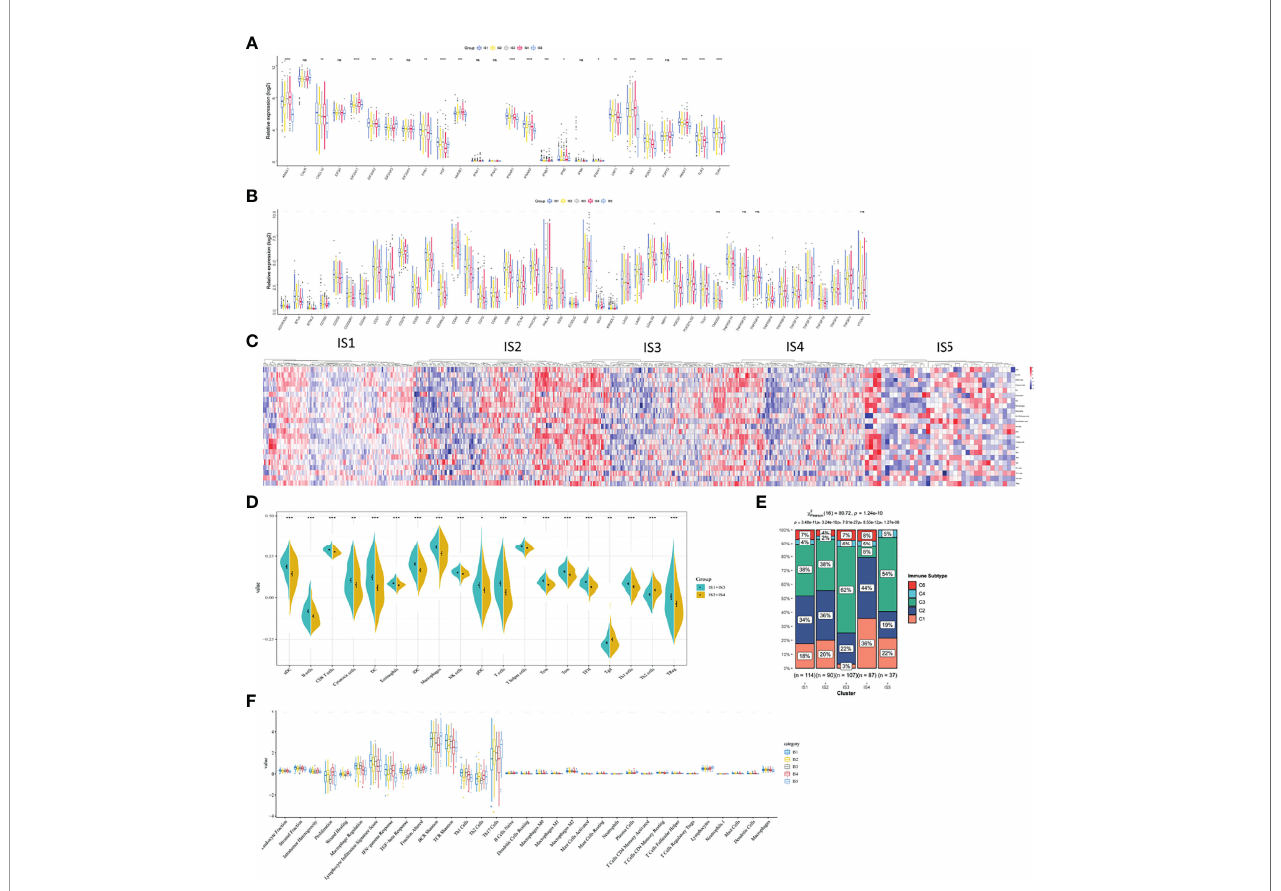
FIGURE 6 | The correlation between LUAD-related ISs and immune modulators and the feature of immune cells in different ISs. (A) Differentially expressed ICP genes in different LUAD ISs. (B) Differentially expressed ICD genes in different LUAD ISs. Kruskal – Wallis test with * p < 0.05, ** p < 0.01, *** p < 0.001, **** p < 0.001. ns presents no difference. (C) Differential enrichment scores of immune cell signatures among fi ve ISs in TCGA cohorts. (D) Differential enrichment scores of ten prognosis-related immune cell signatures. (E) The distribution of fi ve pan-cancer ISs in fi ve LUAD-related ISs. (F) Differential enrichment scores of twenty-four immune